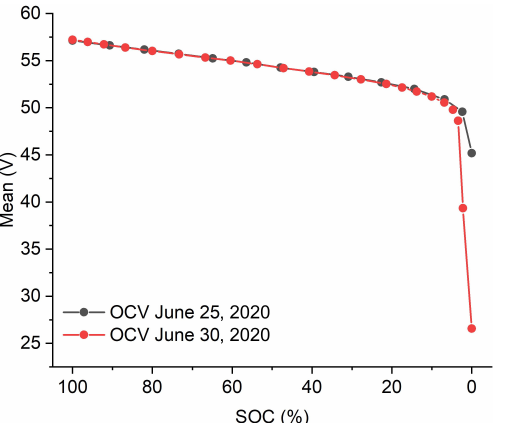
Figure 4. VRFB cycling performance (40 L of electrolyte) with an automatic rebalancing tube, comparing two different charge currents. Cycle ( a ) charge power, ( b ) discharge voltage, ( c ) energy input, ( d ) energy output [22].